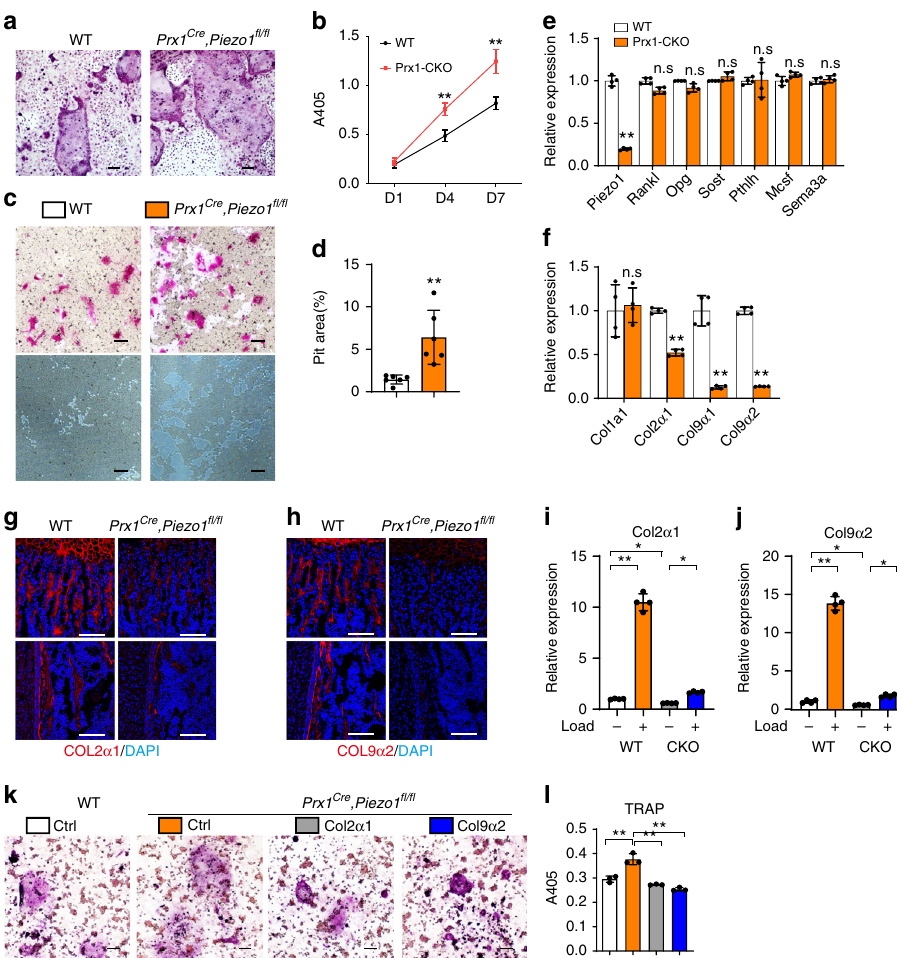
Fig. 5 Col2 α 1 and Col9 α 2 mediated the inhibition of bone resorption by PIEZO1. a – d Osteoclastogenesis by OB-OC co-culture in vitro using BMSCs- derived osteoblasts from WT and Prx1 Cre , Piezo1 fl / fl mice. Scale bar = 100 μ m. a TRAP staining of the osteoclasts in the co-culture system on the normal surface. b Co-culture supernatants were measured for TRAP activity via colorimetric readout (A405) on the normal surface. *P < 0.05; ** P < 0.01. Two- tailed Student ’ s t test. Data are mean ± SD, n = 5. c TRAP staining of the osteoclasts (top panel) and resorption area (bottom panel) in the co-culture system on the bone biomimetic synthetic surface. d Quanti fi cation of the resorption area. * P < 0.05; ** P < 0.01. Two-tailed Student ’ s t test. Data are mean ± SD, n = 6. e , f Indicated gene expression analysis of the cortical bones of WT and Prx1 Cre , Piezo1 fl / fl mice. * P < 0.05; ** P < 0.01. Two-tailed Student ’ s t test. Data are mean ± SD, n = 4. ( g , h ) Immuno fl uorescence assay of COL2 α 1 ( g ) and COL9 α 2 ( h ) of the distal femurs of 3-day-old WT and Prx1 Cre , Piezo1 fl / fl mice. Scale bar = 100 μ m. i , j QPCR analysis of Col2 α 1 ( i ) and Col9 α 2 ( j ) in the BMSCs-derived osteoblasts from WT and Prx1 Cre , Piezo1 fl / fl mice endured with 0.5 Hz, 1% intensity compression for 4 h by FlexCell compression system. * P < 0.05; ** P < 0.01. Ordinary one-way ANOVA. Data are mean ± SD, n = 4. k – l Osteoclastogenesis by OB-OC co-culture in vitro using BMSCs-derived osteoblasts from WT and Prx1 Cre , Piezo1 fl / fl mice infected with Ctrl , Col2 α 1 and Col9 α 2 lenti-virus, respectively. k TRAP staining of the osteoclasts in the co-culture system. Scale bar = 100 μ m. l Co-culture supernatants were measured for TRAP activity via colorimetric readout (A405). * P < 0.05; ** P < 0.01. Ordinary one-way ANOVA. Data are mean ± SD, n = 3. Source data are provided in the Source Data